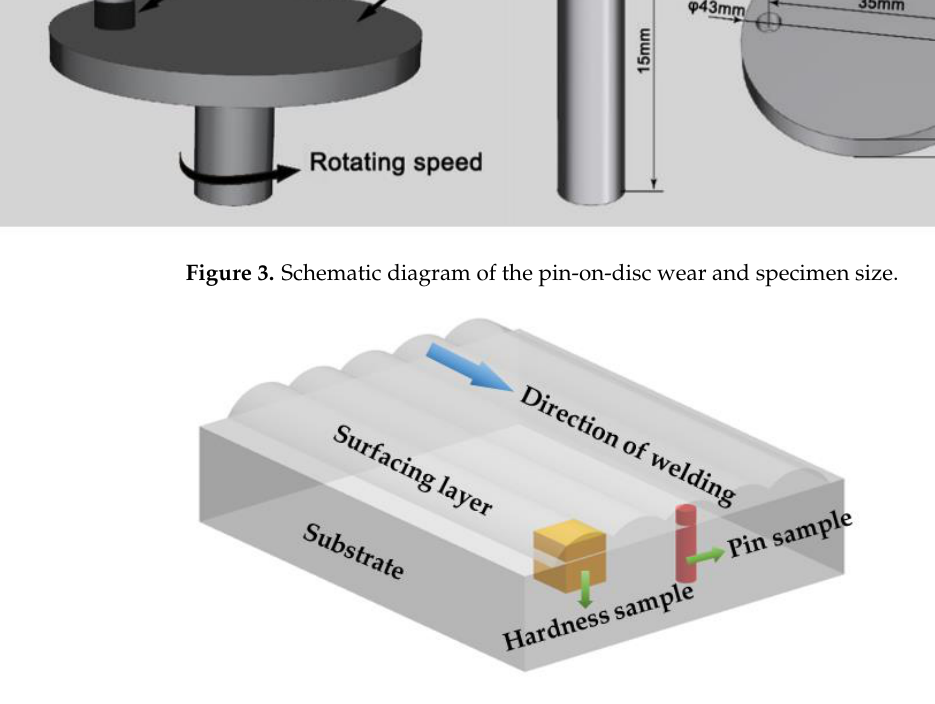
Figure 4. Schematic diagram of sampling location.